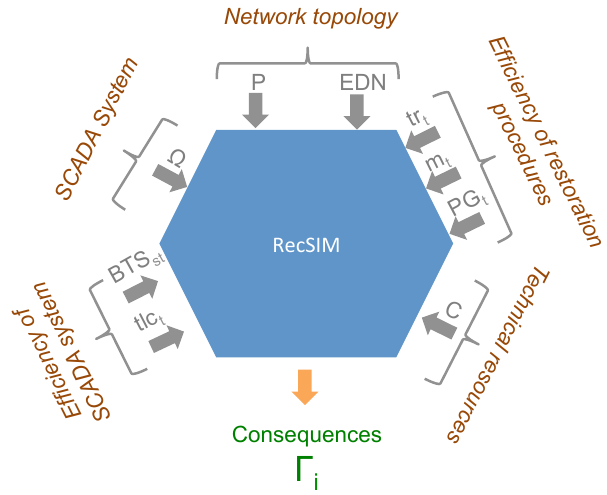
Figure 6. The RecSim simulator inputs and output. The output of RecSim is represented by the value of the impact of the damage scenario (represented by the perturbation P and by its cascading effects) on the EDN, considering all the actions performed (in series or in parallel, as many technical crews were simultaneously available): (a) the damaged node and, whenever the case, the isolated node substitution with a PG; (b) the manual reconnection of disconnected nodes by the available technical crews and (c) the automatic reconnections made through remote tele-control operations. These actions restore the EDN to a normal operating status and allow all users to be reconnected to the grid. As previously stated, damaged SS are just substituted by a PG and, at the end of the simulation, they are still in the damaged state although their function is recovered by the PG. The impact of the perturbation P on the network is thus computed using the Equation (2). Figure 7 shows the different elements of a RecSim EDN model. The electrical MV lines start from primary stations (the node A in Figure 7) and they connect the secondary substations forming, in general a tree structure. As it as already explained in the previous section, some of the secondary substations can be: normal, remotely tele- controlled, automated and “frontier” substations that are represented, respectively, as white, grey, orange and purple nodes in Figure 7. The automated substations are very important as they are able to perform automatically the isolation and restoration procedures needed to react to failures happening to they descendants substations (e.g., the substations P, Q, R, S in Figure 7 are the descendants of the automated substation F). The “frontier” substations can be used to restore a portion of an MV line from another MV line backup